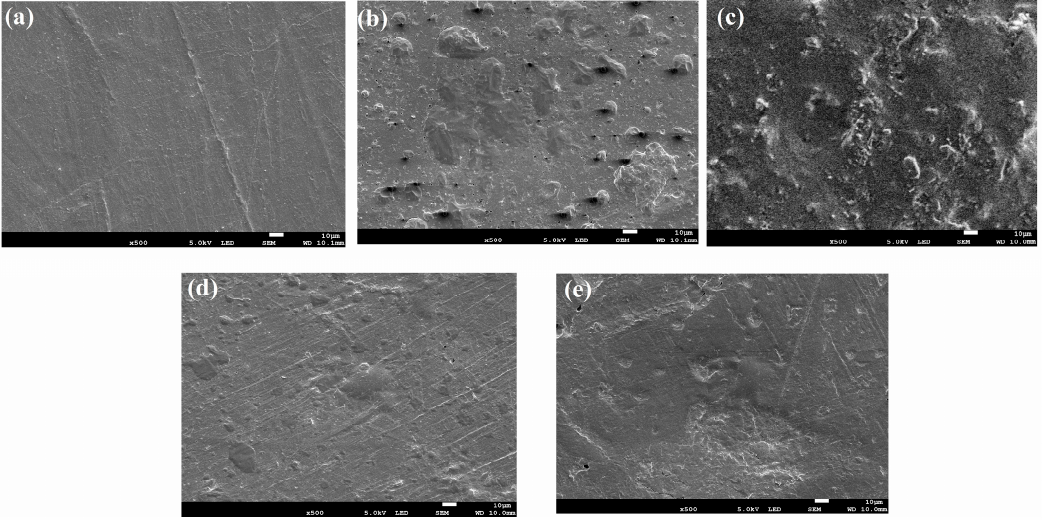
Figure 5. SEM images of surface morphology obtained by ( a ) P/15B, ( b ) P/15B/10PA-PEI, ( c ) P/15B/15PA-PEI, ( d ) P/15B/10PA-Arg and ( e ) P/15B/15PA-Arg.